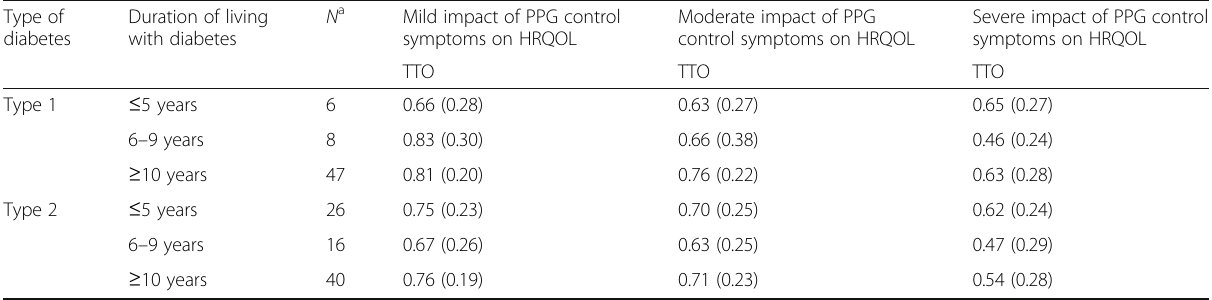
Table 4 Time trade-off (TTO) exercises in the Swedish ( n = 150) analysis sets per diabetes type and duration of living with diabetes, presented as mean (SD) Type of